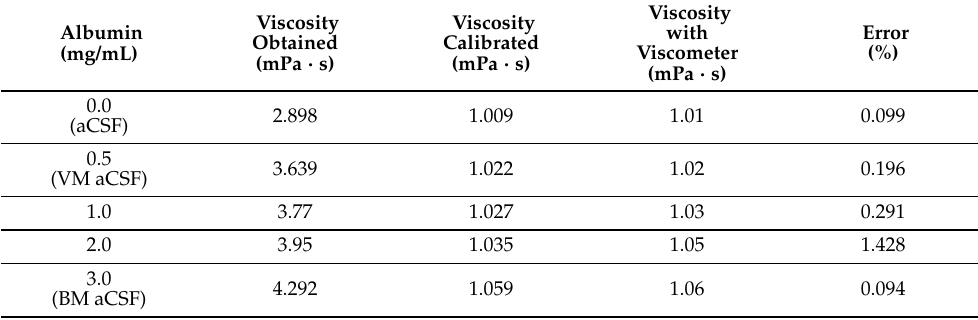
Table 10. Resulting viscosity after calibration for